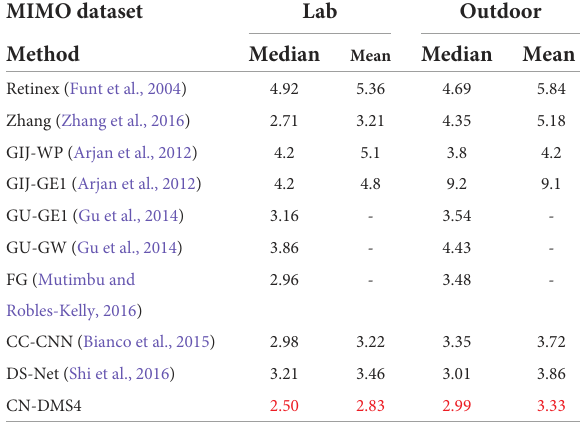
TABLE 2 Quantitative Evaluation on MIMO (Beigpour et al., 2014), red indicates the best. MIMO dataset